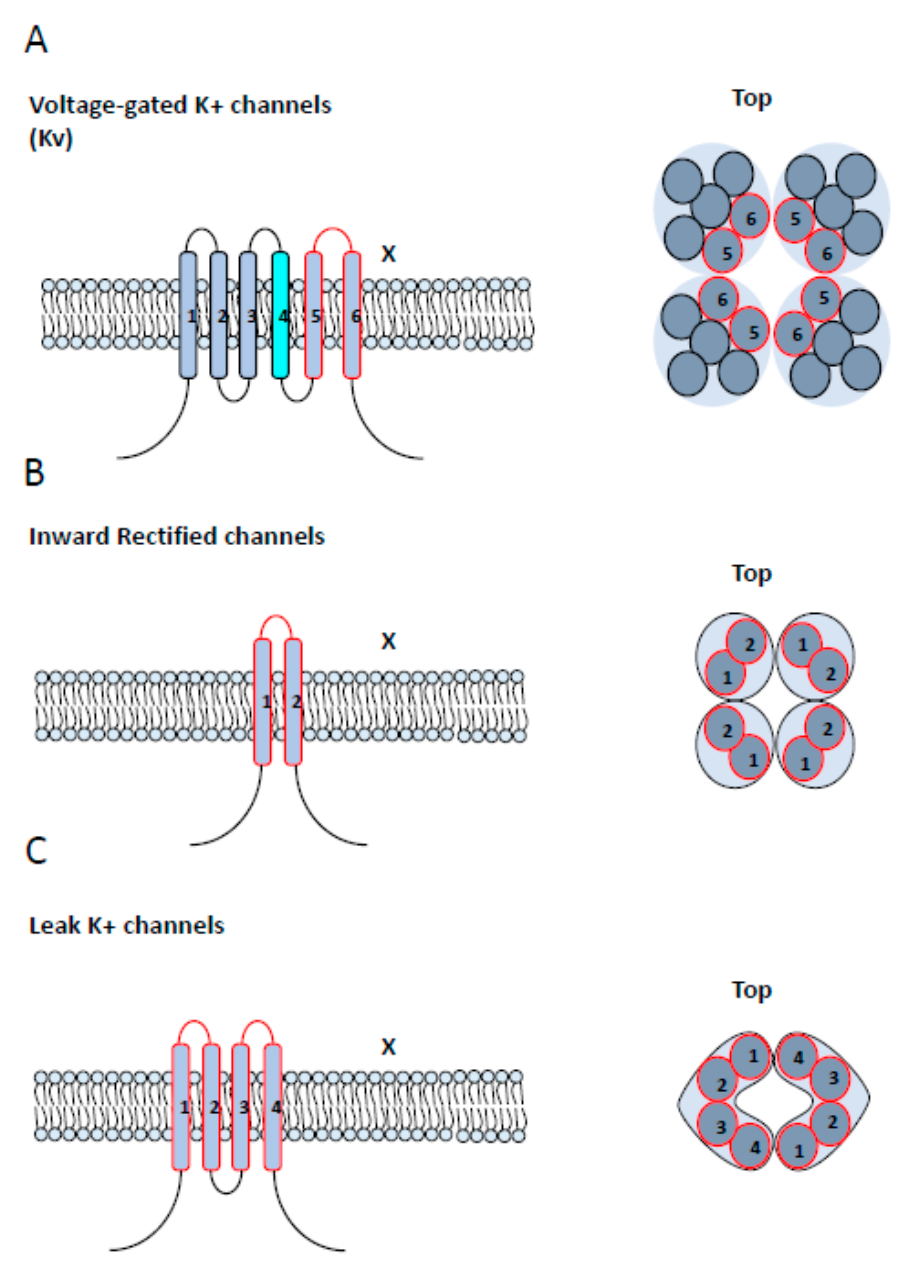
Figure 6. Structural classification of K + channels. ( A ) Left: the voltage-sensitive (Kv) and calcium-sensitive K + (Kca) channels show a similar structure with six transmembrane segments (TMS) and a pore-domain formed by TMS 5 and 6, shown in red. The Kv channels differ in that they contain a voltage sensor in TMS4, shown in cyan. Right: A top view of Kv and Kca channels, showing the six TMS of each of the four subunits and their corresponding pore-forming loops, shown in red. The functional channel is a tetramer protein (x4). ( B ) Left: a lateral view of monomers of an inward rectifier potassium channel (Kir), showing two TMS connected by a pore-forming loop, shown in red. Right: a top view of Kir channel, showing the convergence of four units of Kir channels to the channel pore. The functional channel is a tetramer protein (x4). ( C ) Left: topology of a two-pore domain potassium channel (K2P), showing four TMS and two pore domains. Right: a top view of K2P channel, showing the convergence of two units of K2P to form the channel pore. The functional channel is a dimer protein (x2).